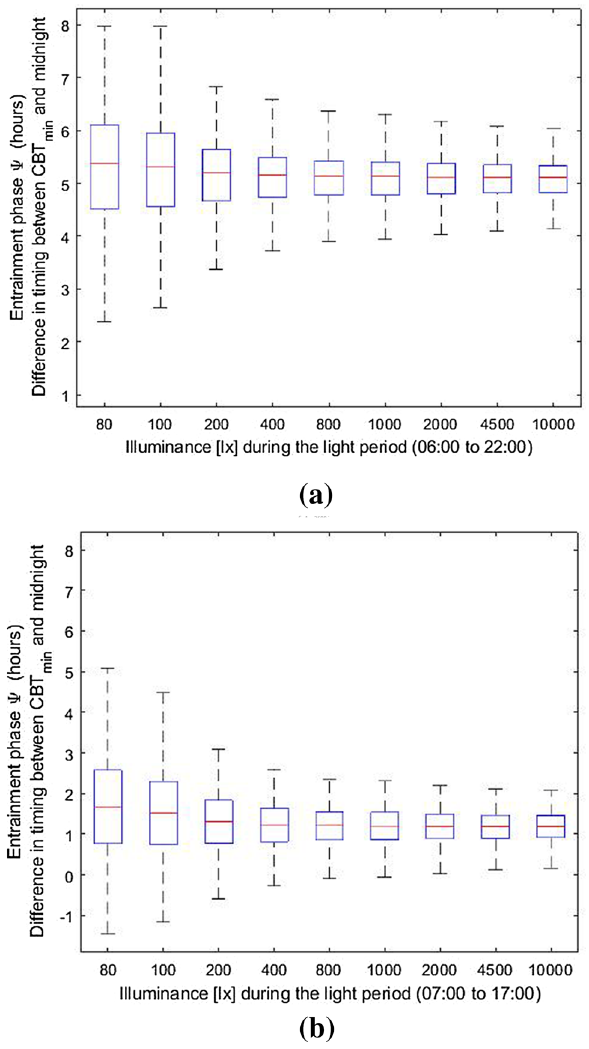
Figure 1. Entrainment phase angle distribution for a population of 200 simulated individuals with a normally distributed intrinsic circadian period with means (± SD) of 24.15 (± 0.2) h 33 when entrained to various corneal illuminances (i.e., at the eye position). ( a ) Results for the LD 16:8 schedule. ( b ) Results for the LD 10:14 schedule. The central marker indicates the median, and the bottom and top edges indicate the 25th and 75th percentiles, respectively. The whiskers indicate the most extreme data points (population minima and